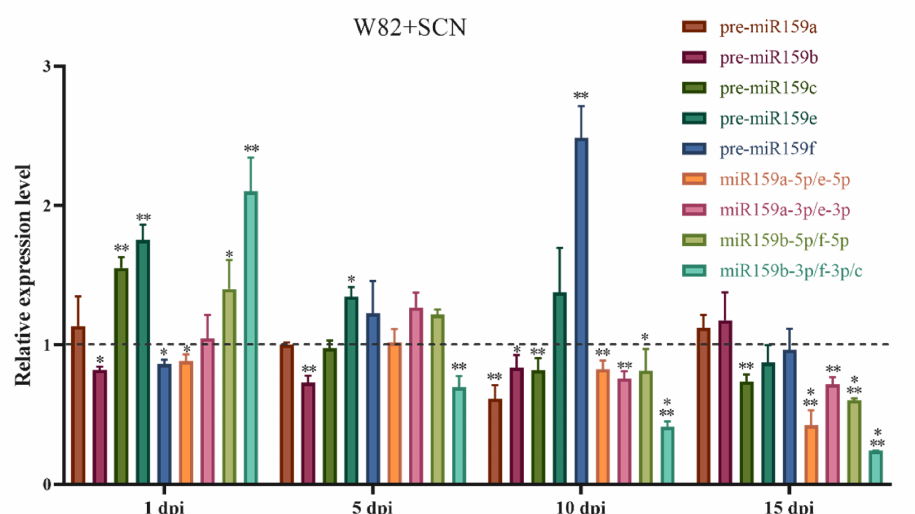
Figure 1. Time-course expression analysis of soybean miR159 during soybean cyst nematode (SCN) infection with suscepti- ble cultivar Williams 82. dpi, post-inoculation. The expression of precursors and miR159 members in Williams 82 inoculated with SCN (W82 + SCN) and was relative to Williams 82 control (W82CK) at each time point. Soybean U6 gene was used as internal reference gene. Statistical comparisons were made with the t -test for every soybean miR159 member and precursors between W82 and W82 + SCN at each time point. Significant differences between each comparison found at p < 0.05, p < 0.01 and p < 0.001 level were marked with *, ** and ***,